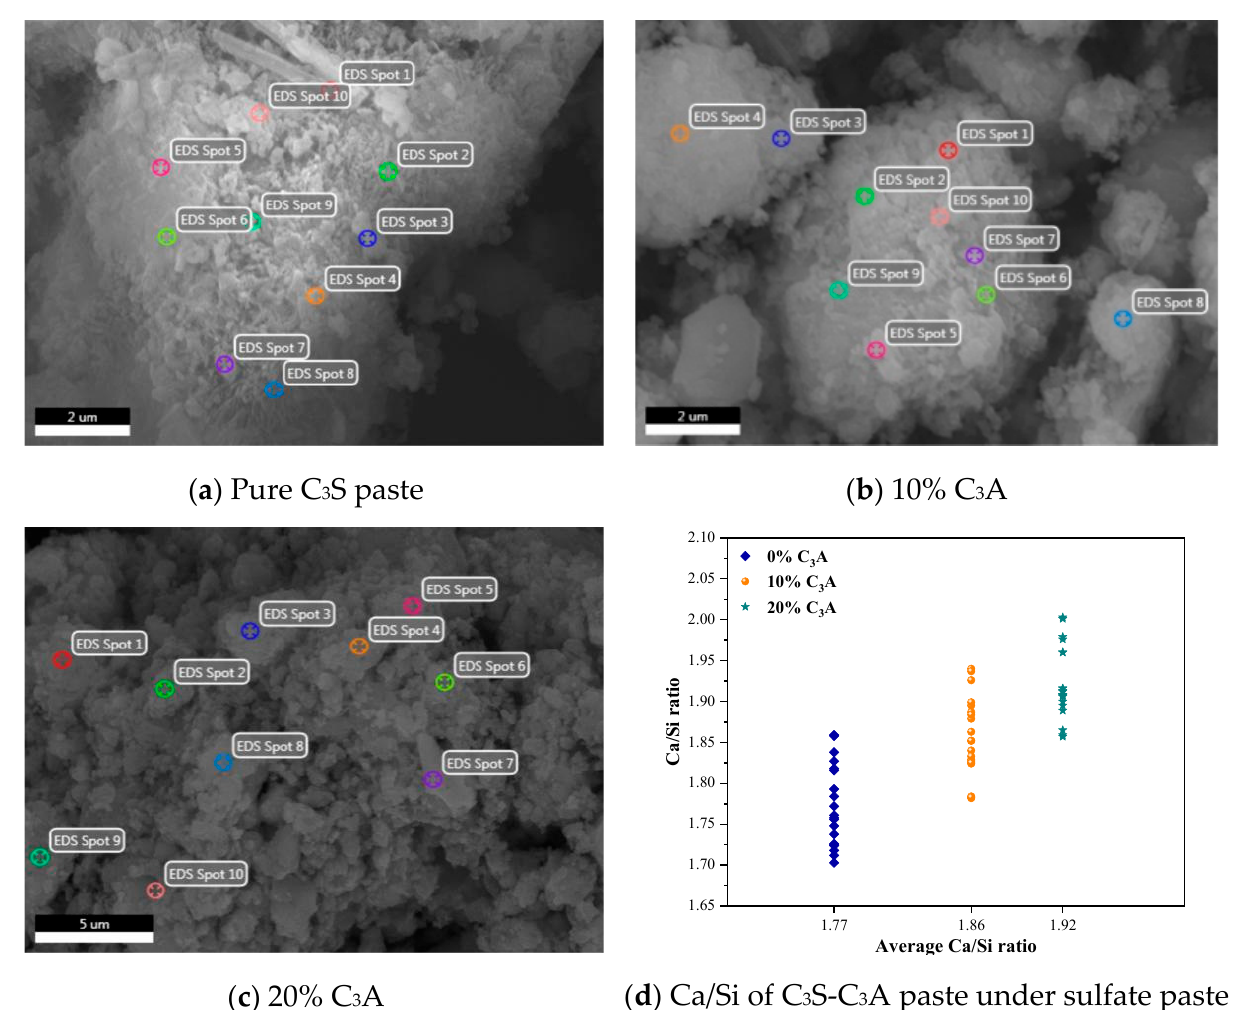
Figure 7. SEM – EDS spectra of C 3 S-C 3 A paste under sulfate attack. Figure 7. SEM–EDS spectra of C